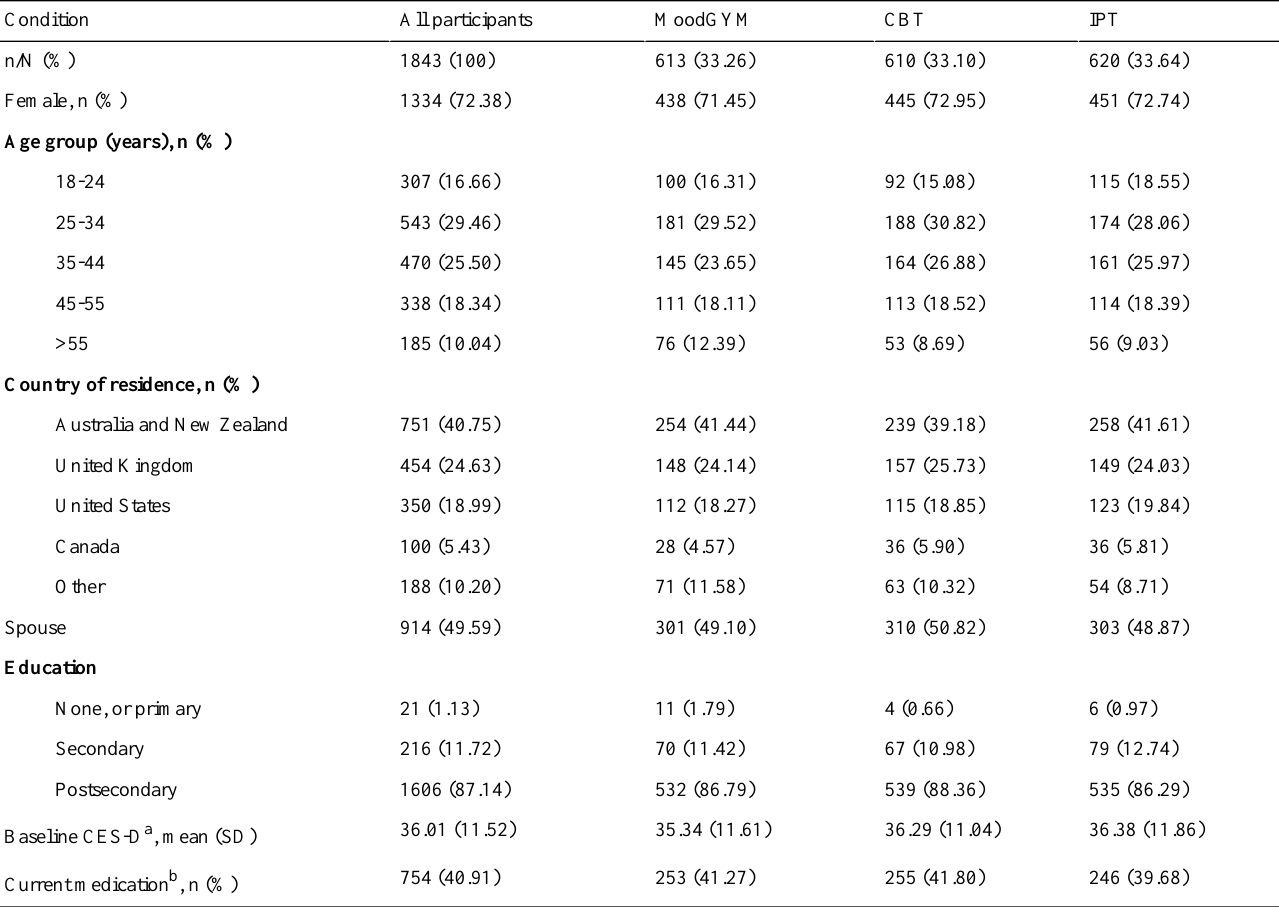
Table 1. Baseline demographic, socioeconomic, and clinical characteristics of participants for the e-couch cognitive behavioral therapy (CBT), the e-couch interpersonal psychotherapy (IPT), and the MoodGYM